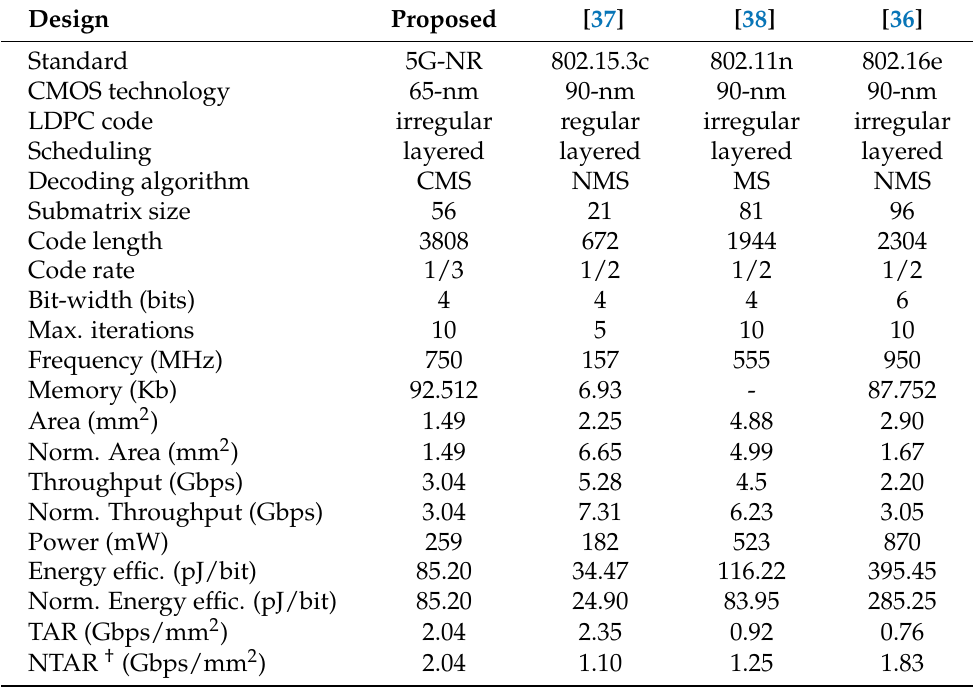
Table 5. Implementation and comparison for 5G QC-LDPC